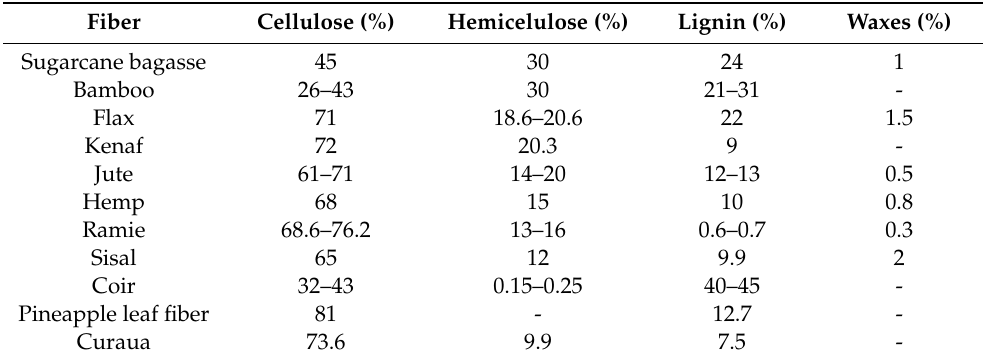
Table 2. Chemical composition of natural fibers. Adapted from Reference [38] with the permission of